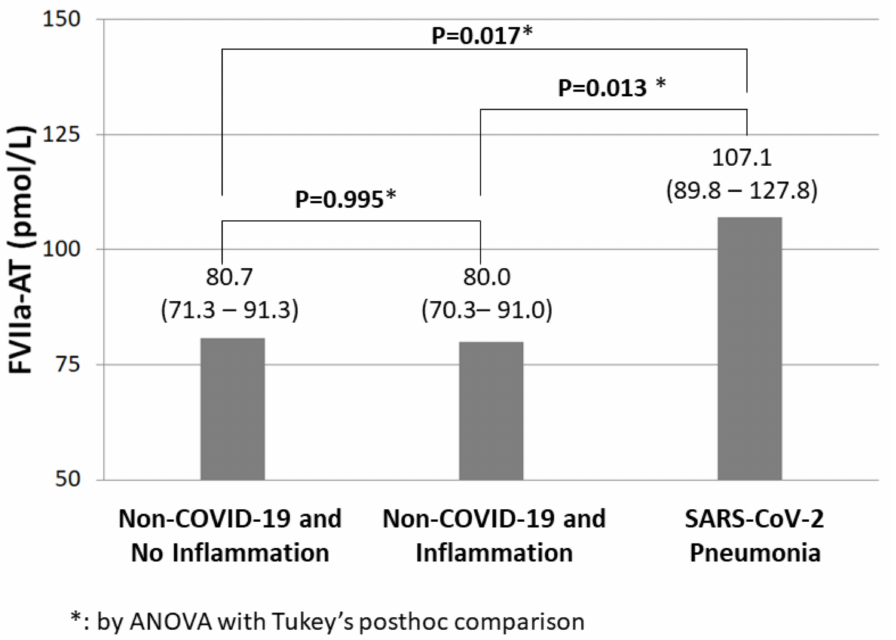
Figure 2. FVIIa-AT levels in subjects with or without SARS-CoV-2 infection. Activated factor VII– antithrombin complex (FVIIa-AT) plasma concentration in the three study groups. Defining high levels of FVIIa-AT on the basis of the arbitrary threshold of the 90th percentile in subjects without COVID-19 and without signs of inflammation, subjects with SARS-CoV-2 pneumonia had a three-fold increased prevalence of high FVIIa-AT levels compared with non-COVID-19 subjects, either with or without inflammation (Figure 3).